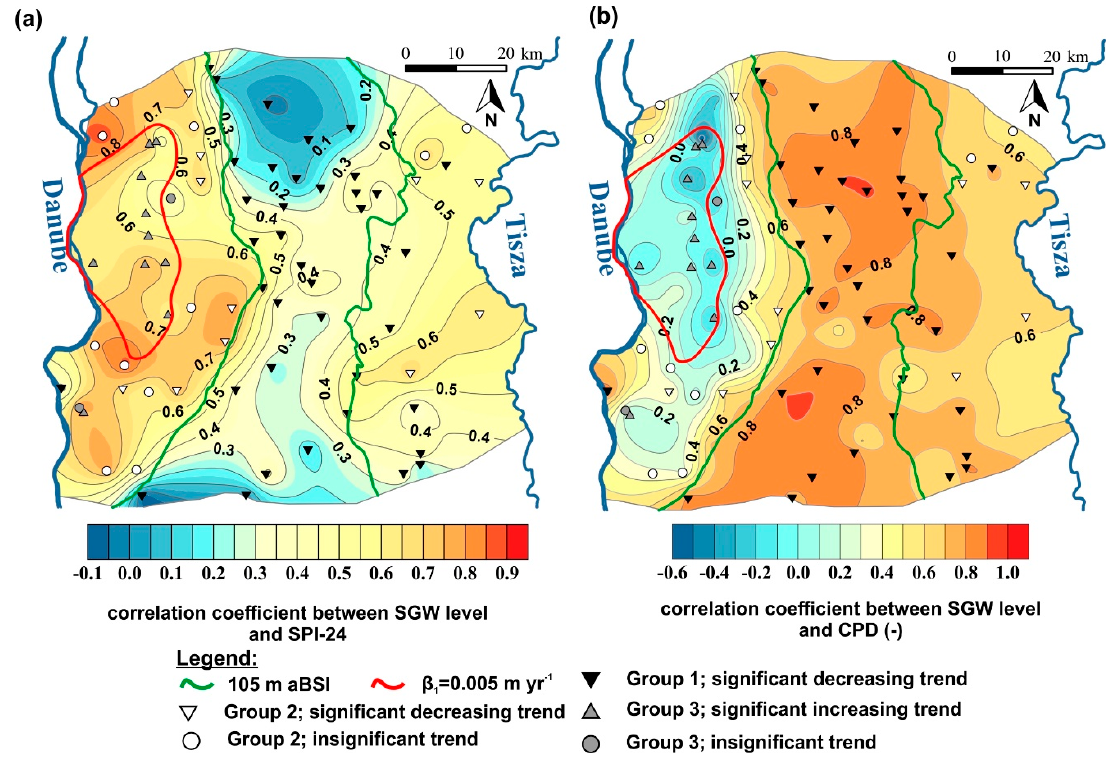
Figure 6. Map of the correlation coefficients between Standardized Precipitation Index (SPI-24) and the SGW level time series ( a ) and cumulative precipitation departure (CPD), and the SGW level time series ( b ). The properties of the semivariograms can be found in Figure S6d,e.